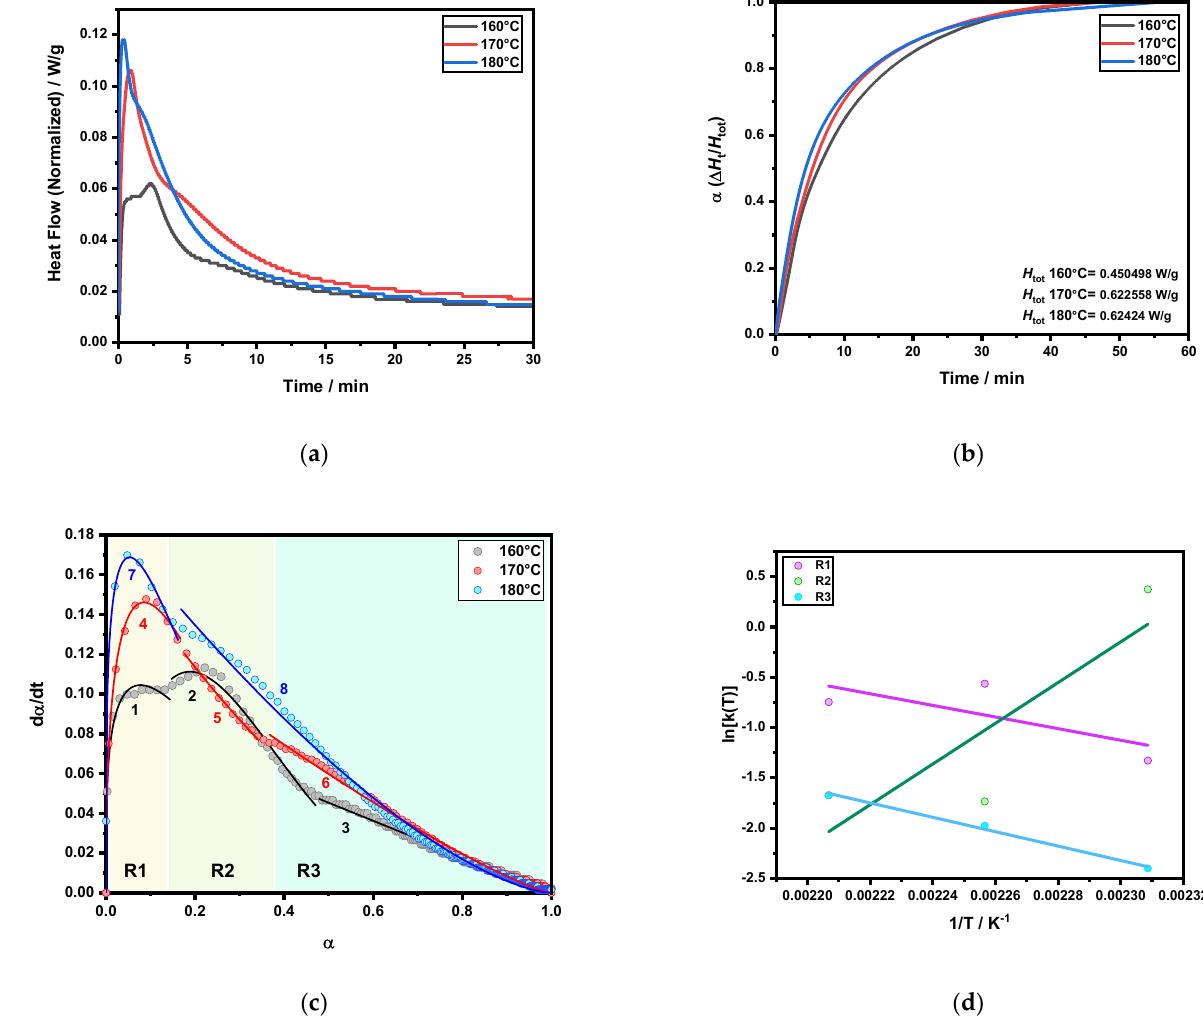
Figure 2. Kinetics and curing parameters derived from isothermal DSC analysis of CR/TLP 2%: ( a ) heat flow vs. time at temperatures at 160 °C, 170 °C and 180 °C; ( b ) degree of cure calculated; ( c ) autocatalytic model fitting for the domains of Reaction 1 (R1), Reaction 2 (R2) and Reaction 3 (R3); the indices from 1 to 8 are related to the fitting parameters reported in Table S1; ( d ) activation energy, E a , and pre-exponential factor k 0 obtained from the slope and intercept values, respectively, of the linear regression, in solid lines, for three distinctive reactions occurring during curing.